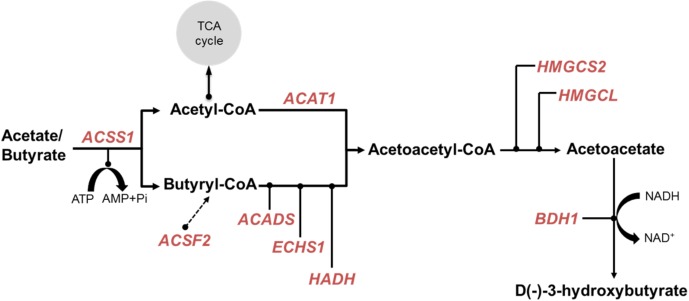
Simplified ketone body metabolic pathway. Key enzymes were based on the encoding genes which were present in both AUS and NZ (Xiang et al., 2016a) metabolism gene networks. These presented genes were indicated by red text. Dashed arrow represents a hypothesized contribution of ACSF2 to butyryl-CoA synthesis.